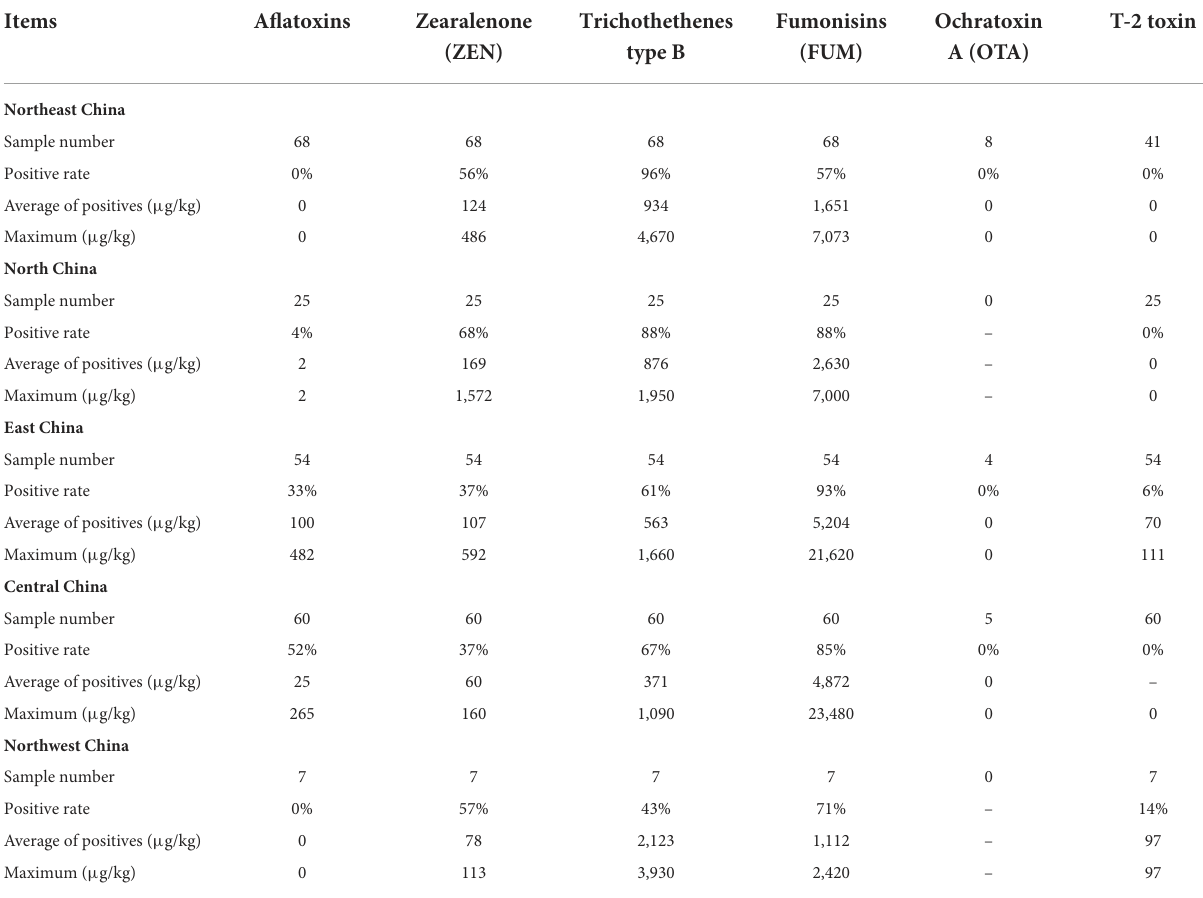
TABLE 6 Mycotoxin occurrence in new season corn in different regions of China.